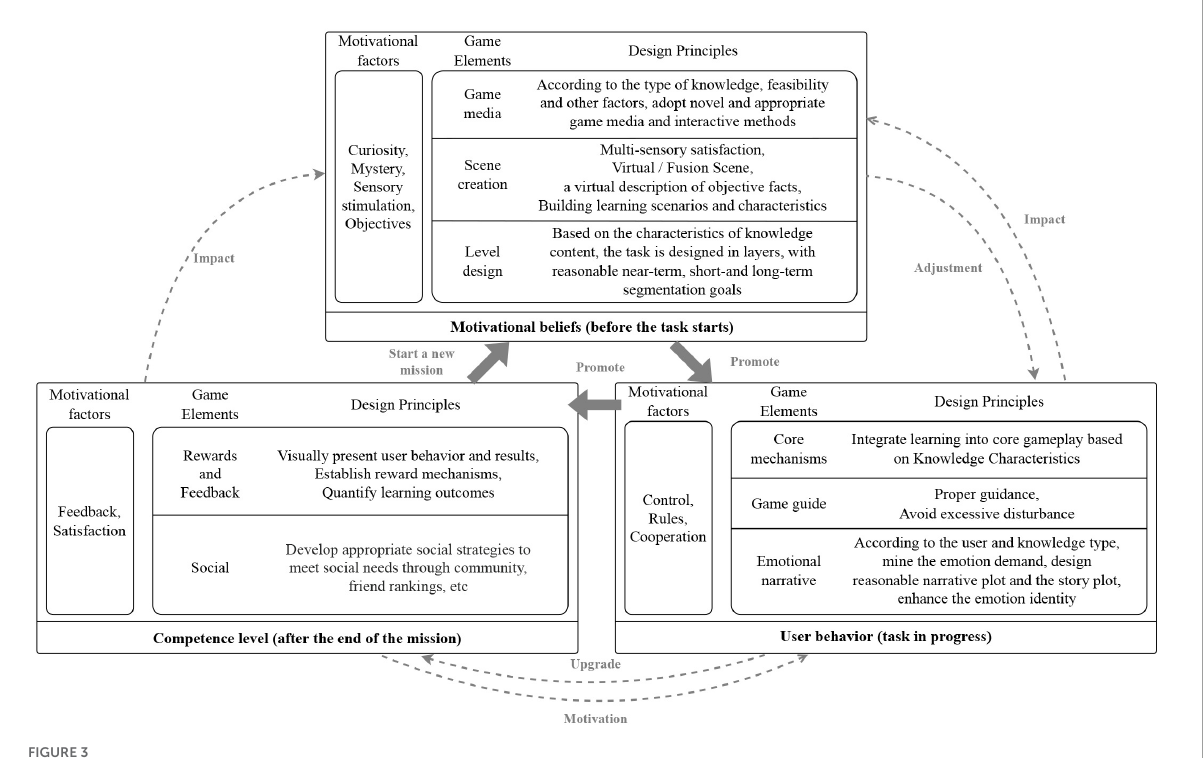
FIGURE3 A framework for motivation-oriented educational game